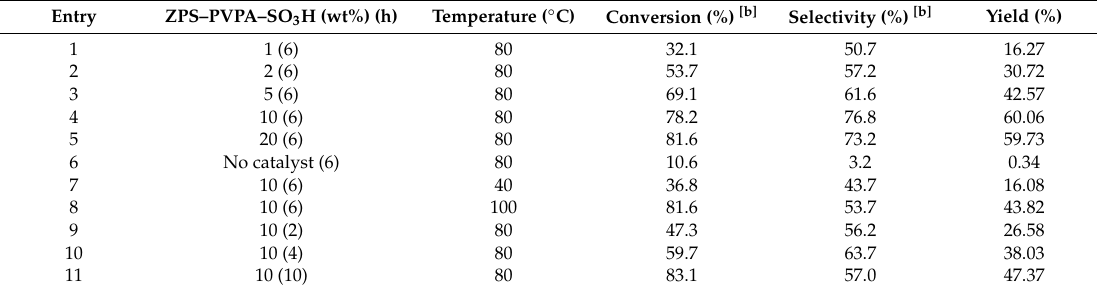
Table 2. The results of the quantity screening of ZPS–PVPA–SO 3 H in the epoxidation of soybean oil. [a]